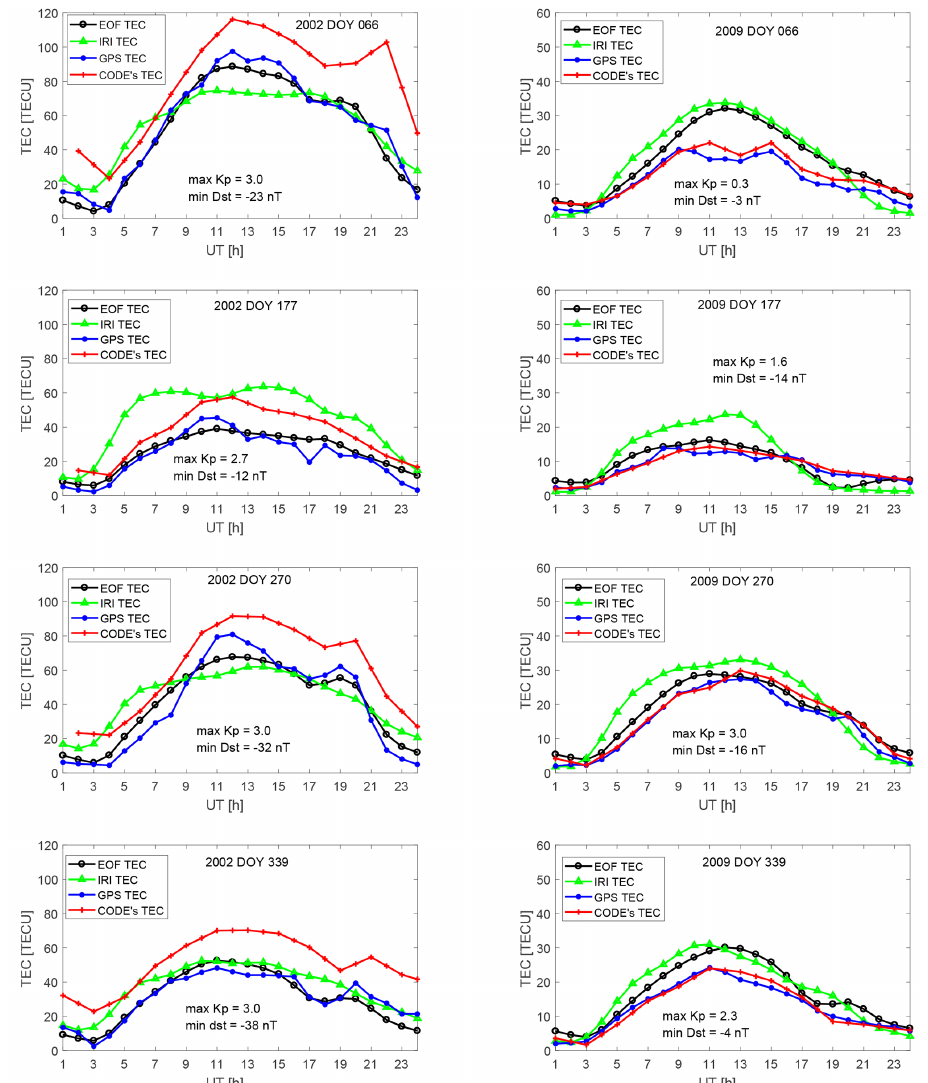
Figure 3. GPS TEC, IRI TEC, CODE’s TEC and EOF TEC over Malindi for some selected quiet days. Included in each plot are the maximum Kp and the minimum Dst index for the